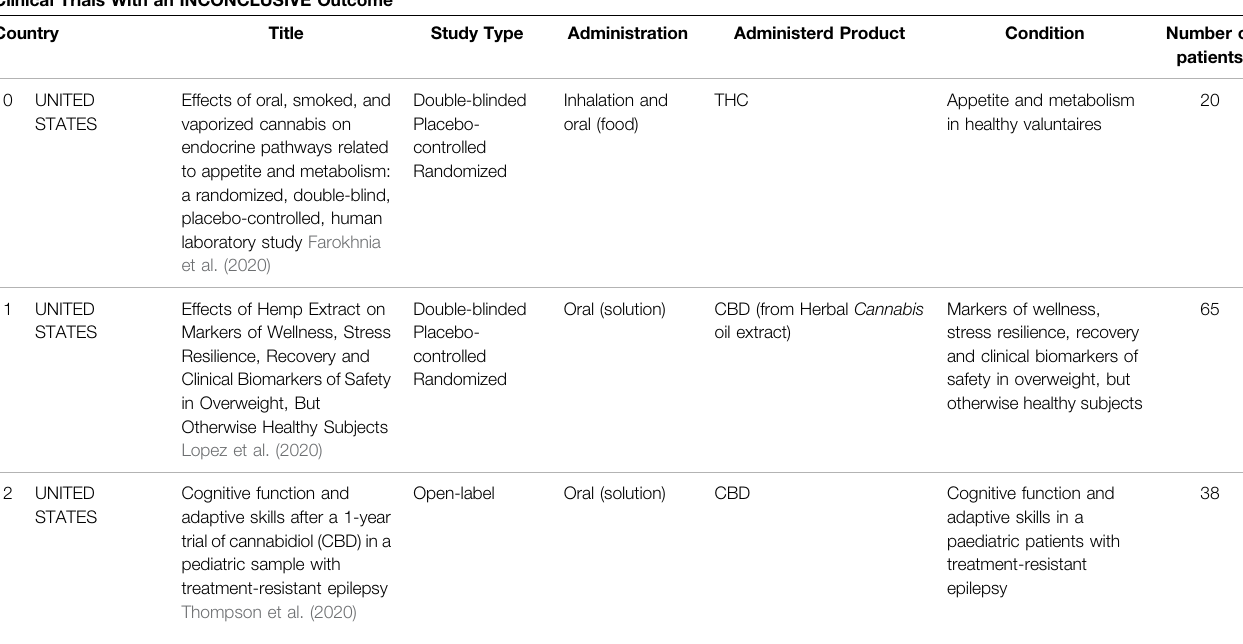
TABLE 1 | ( Continued ) Characteristics of the selected clinical